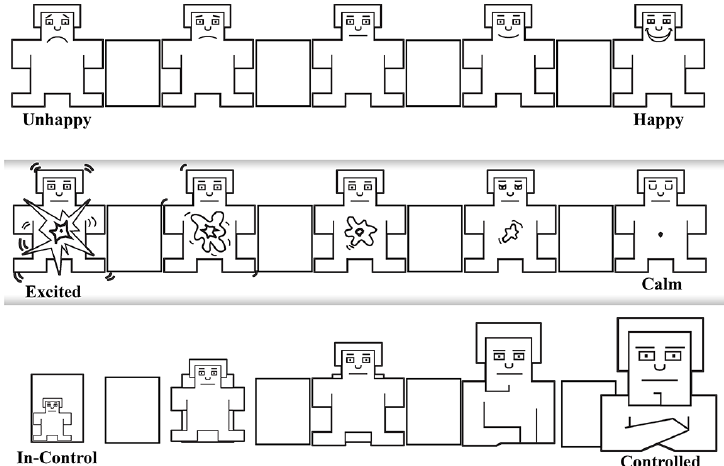
Figure 4. Self-assessment manikin. A set of images is used to value valence ( top row ), arousal ( middle row ) and dominance ( bottom row